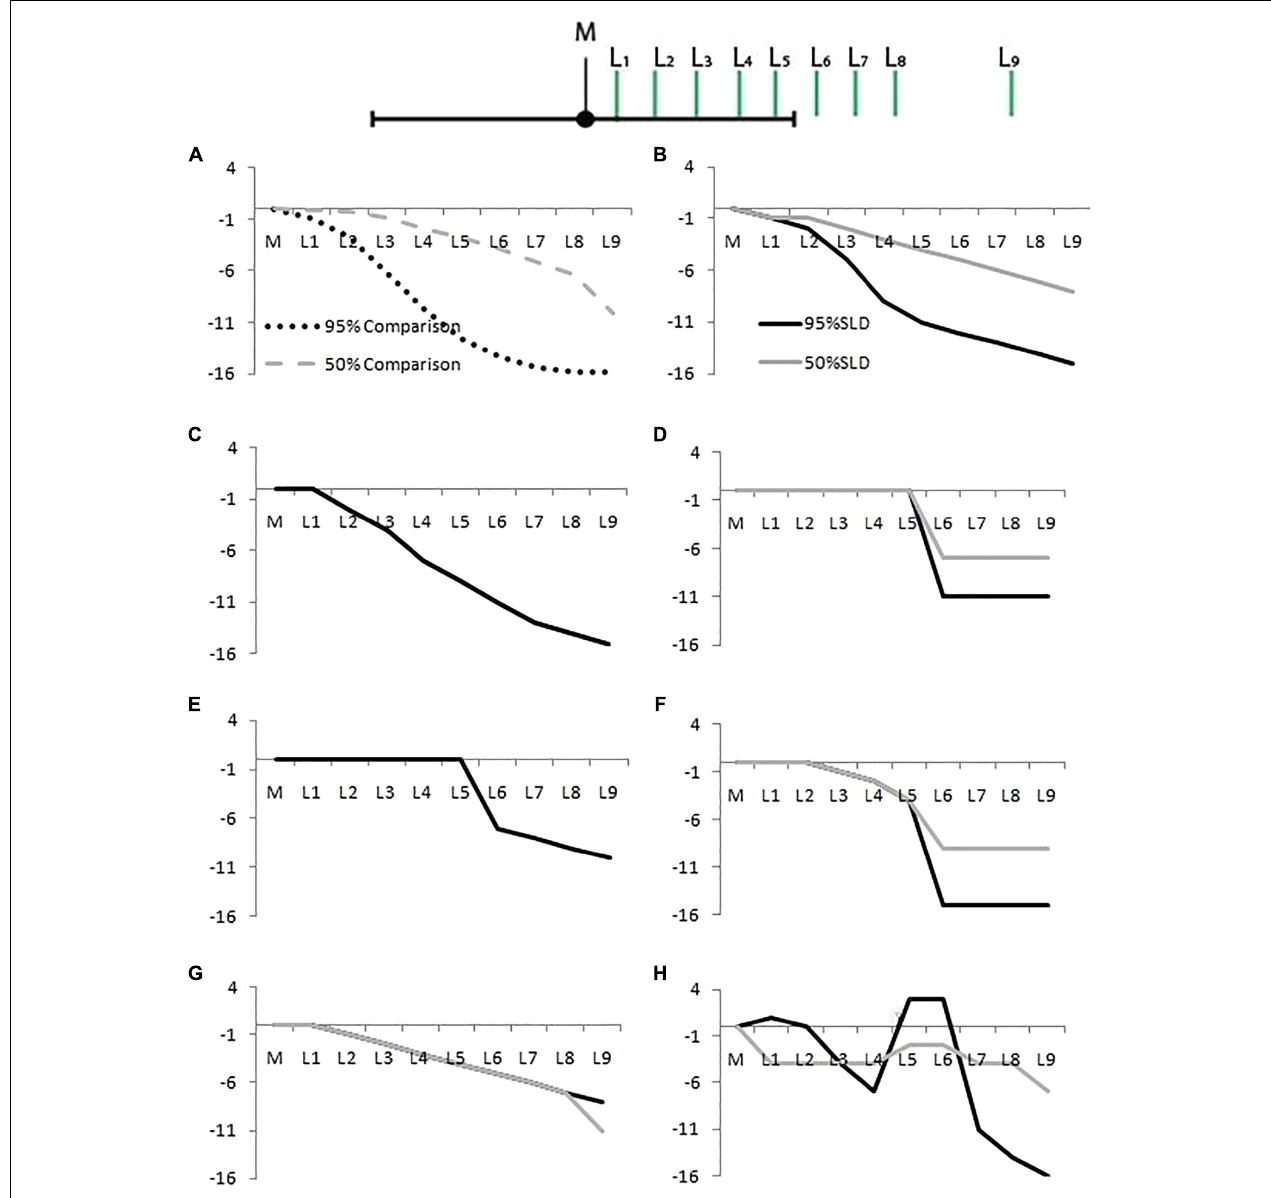
FIGURE 4 | Likelihood distribution curves, for 50% (gray lines) and 95% CIs (dark lines). (A) The correct shape for a 95% CI (dotted line) and 50% CI (dashed line). The other panels show examples of student responses classified as: (B) Correct, (C) Gradual Curve (gray and dark lines coincide), (D) Square, (E) Mesa (gray and dark lines coincide), (F) Half Circle, (G) Triangle, and (H) Other. The X -axis represents points L 1 to L 9 as in Figure 1 . The Y -axis represents the difference in rated likelihood on a 19-point